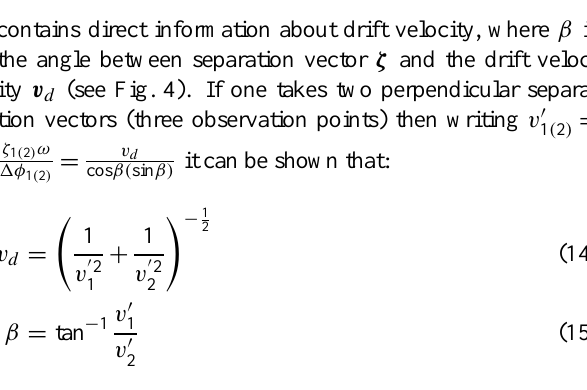
Fig. 6. Phase-frequency distribution for two pairs of receivers – upper for S-N pair and lower for E-W pair